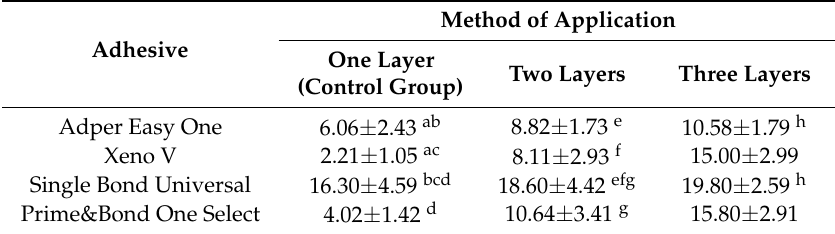
Table 2. Shear bond strength [MPa] (mean values ± standard deviation) of the tested adhesives.